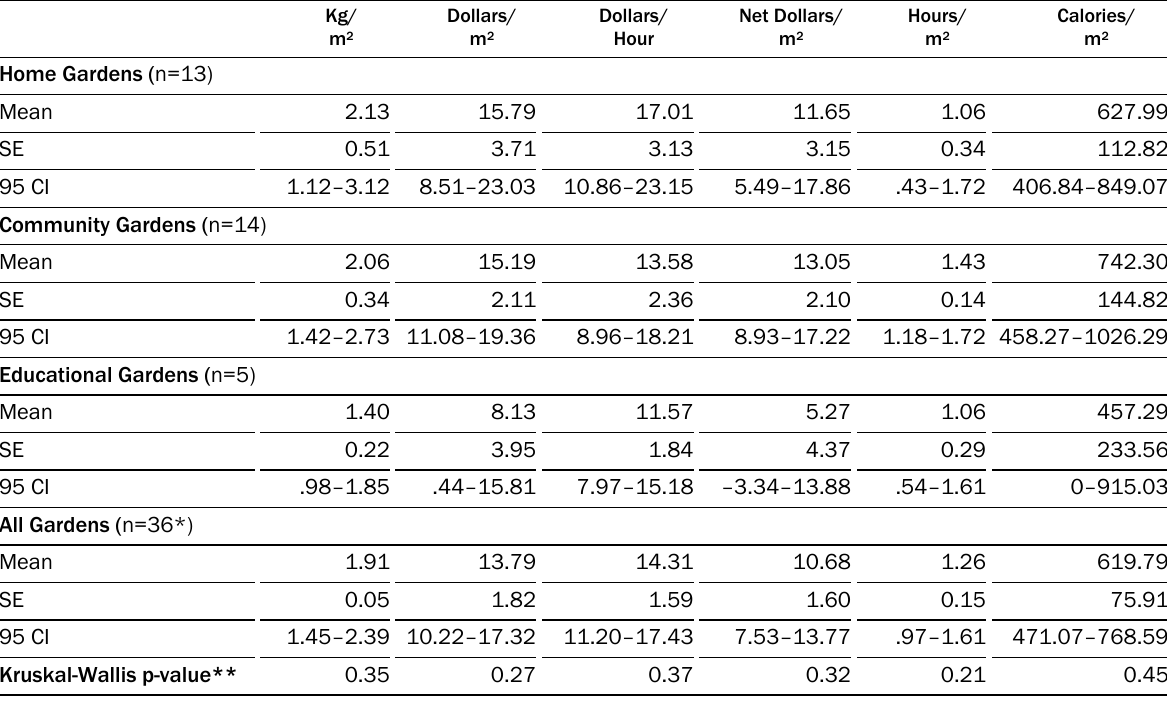
Table 3. Productivity of CFP Resources Aggregated by Resource Type Shown with Kruskal-Wallis p-Values of Variance Between Aggregation